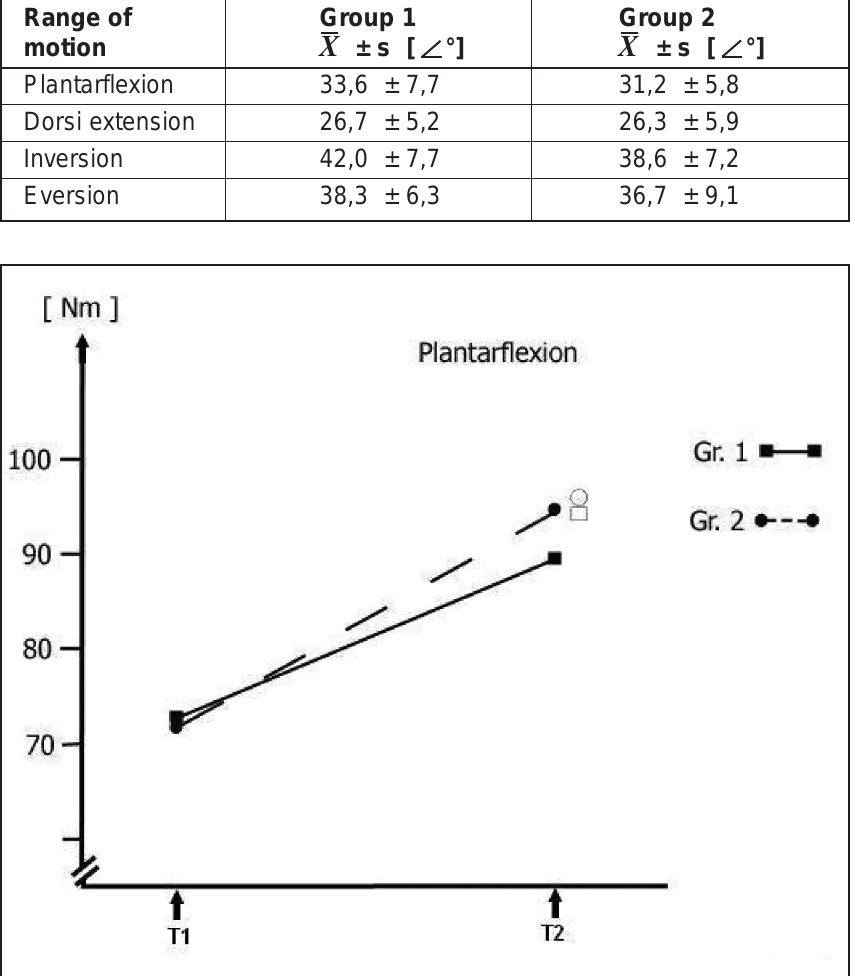
Figure 1: Maximum isokinetic torque in plantar flexion of the injured ankle in the comparison groups at the beginning of the investigation (T ) and at the end of the investigation (T 1 torque on the uninjured